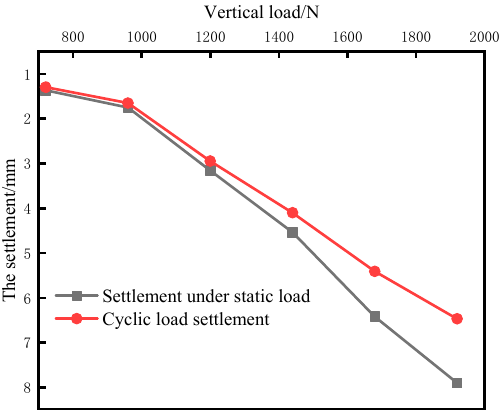
Figure 8. The cyclic–static displacement ratio curve.